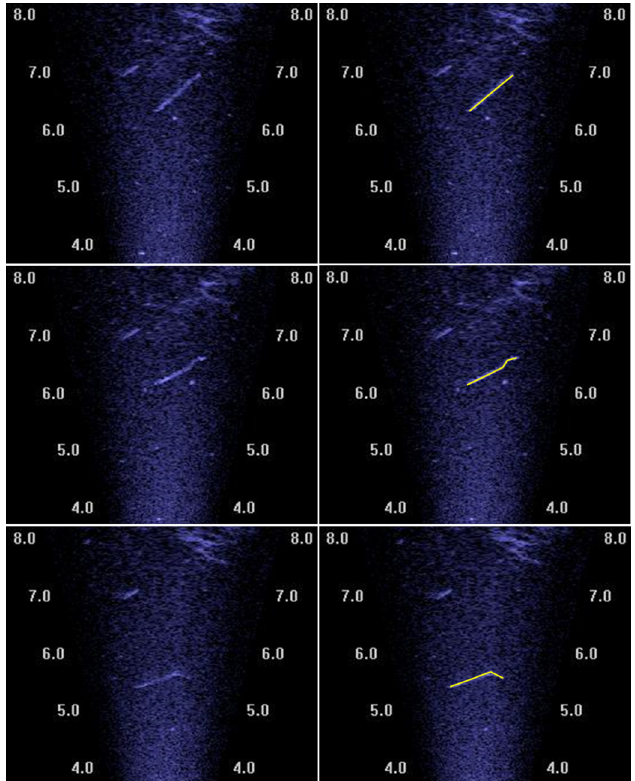
Fig. 1. Left: echoes of the same large fi sh in successive frames from the DIDSON (from top to bottom: frames 66, 73, 115); right: automatic tracking of the fi sh and “ backbone ” drawing with the Sonar5-Pro